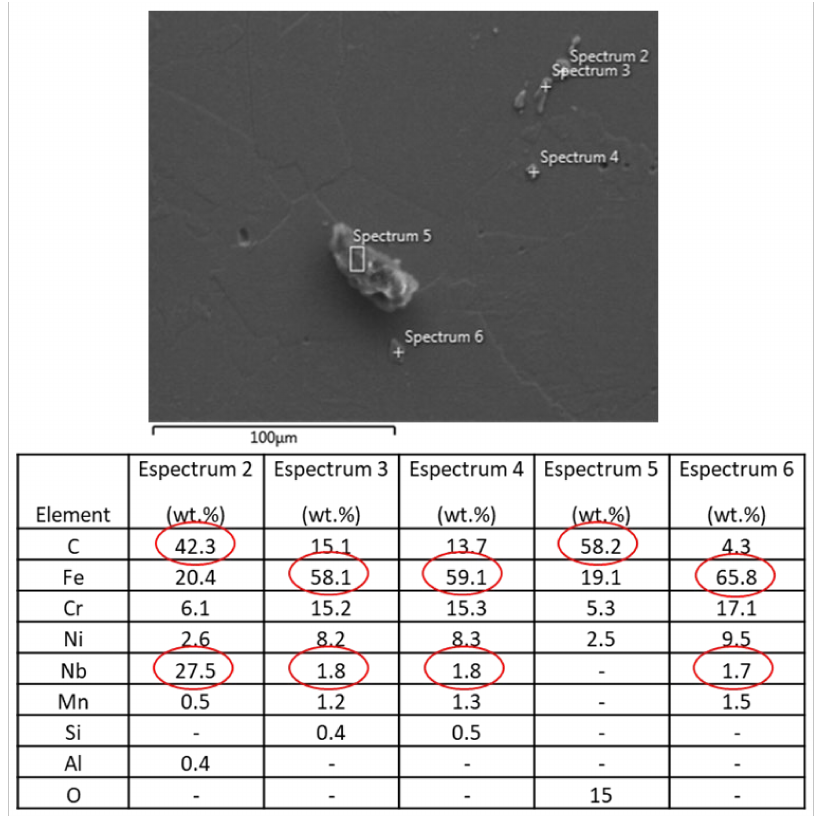
Figure 12. EDS analysis of phases found in the substrate. The more important elements were indicated by red circles.